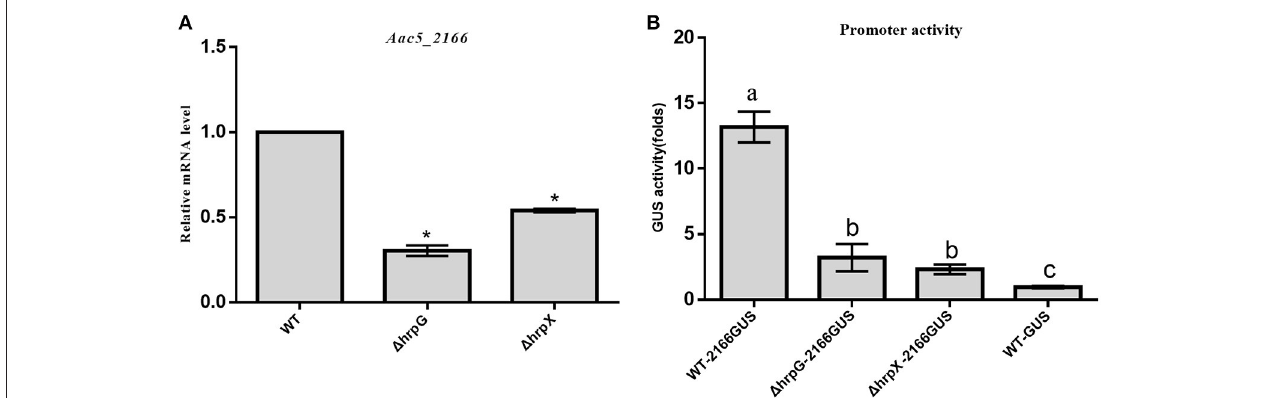
FIGURE 8 | Effects of hrpG and hrpX genes on the regulation of type 3 effectors in Acidovorax citrulli . (A) Real-time quantitative RT-PCR was used to determine Aac5_2166 mRNA levels. Putative type 3 secreted effector (T3E) Aac5_2166 gene expression was assayed through RT-qPCR in wild-type strain Aac5 and the hrpG and hrpX deletion mutant strains, using specific primers. The data shown are means ± standard deviation of duplicate samples from one representative experiment and are reported as fold induction relative to expression of WT. The rpoB gene was used as a reference gene. The experiment was performed three times, with similar results obtained each time. Asterisks above bars indicate significant differences as determined by t -test, p < 0.05; (B) The detection of promoter activity of the putative T3E Aac5_2166 was determined by assaying GUS activity. The pBBR2166GUS was constructed with Aac5_2166 native promoter and GUS reporter